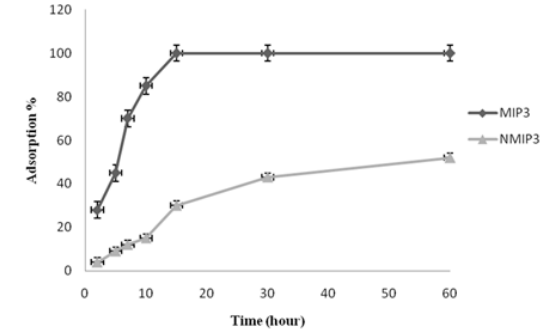
Figure 9. Effect of time on rebinding efficiency of tramaddol. 50mg of the imprinted polymers; sample volume: 5 mL; tramadol concentration: 50 µg L −1 ; pH 7.5; temperature 20°C (mean±S.D., n=3).